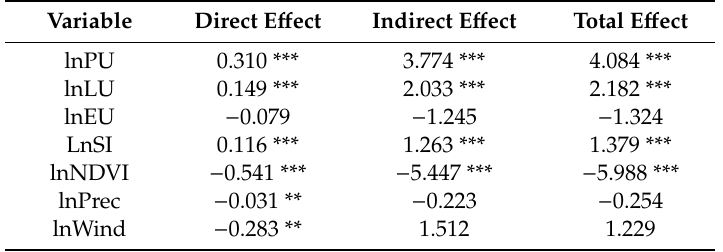
Table 7. Direct, indirect and total e ff ects of the seven explanatory